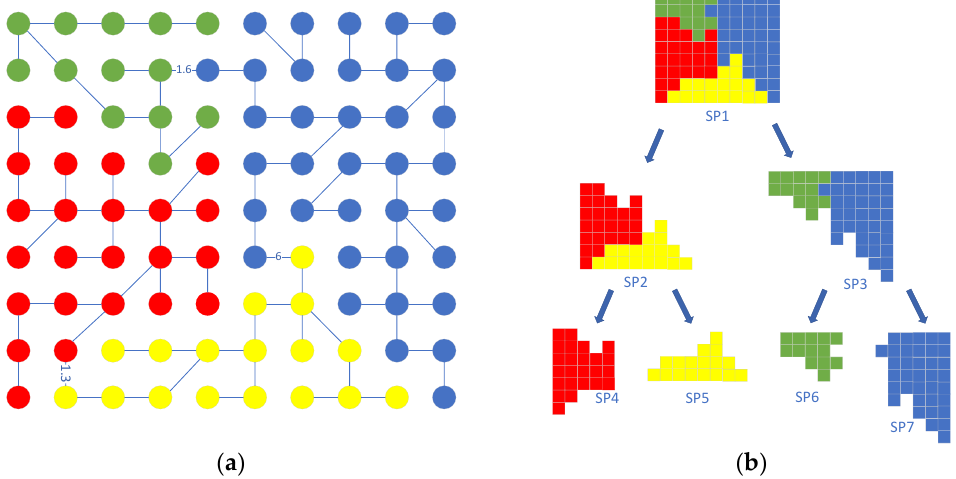
Figure 2. Presentation of image segmentation using MST methods . (a) MST structure of a PolSAR image. (b) Hierarchical segmentation process.